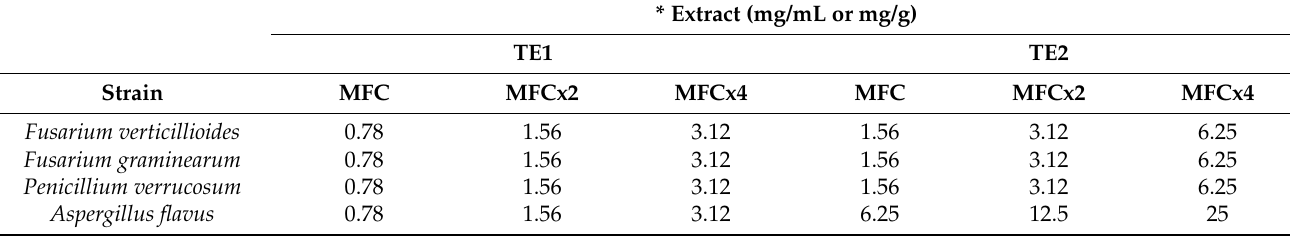
Table 1. Concentrations of extracts TE1 and TE2. Three different concentrations were tested: the MFC as determined in a previous study [27], the double (MFCx2) and the quadruple (MFCx4) of MFC. * The concentration of extracts as mg/mL for tomatoes and mg/g for maize and